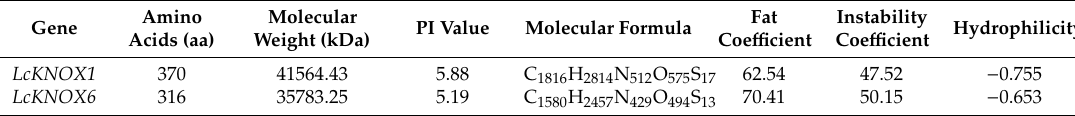
Table 1. Analysis of the protein physical and chemical properties.